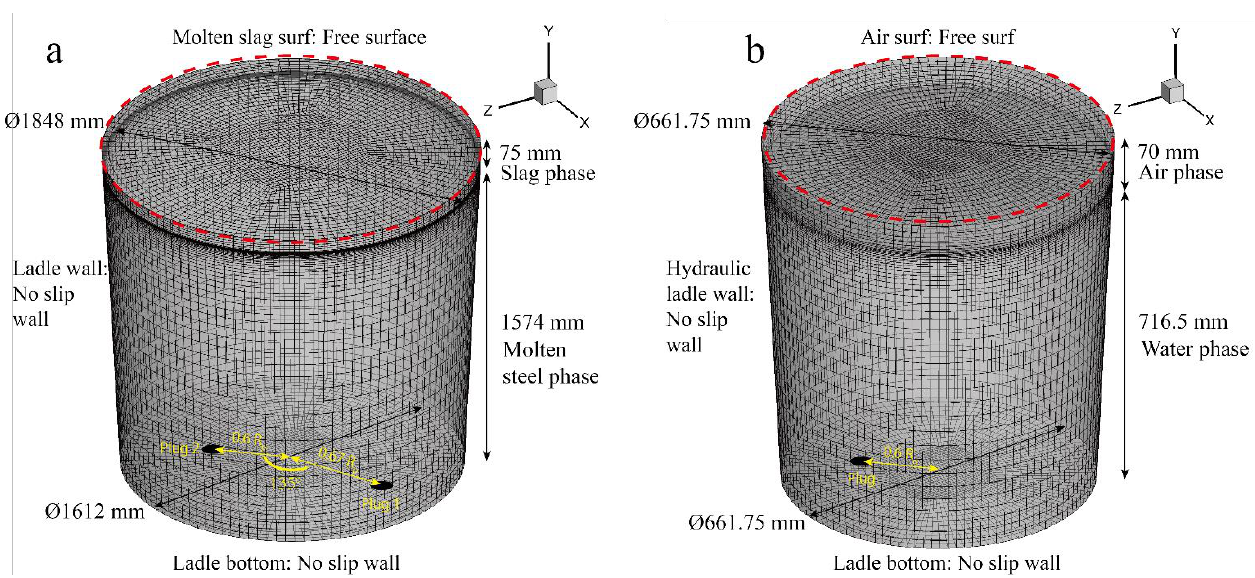
Figure 3. Hexahedral mesh of the fluid zone, boundary name, boundary condition, and the schematic of the argon injection position: ( a ) prototype; ( b ) hydraulic model. Table 2. Relevant parameters in the numerical simulation.